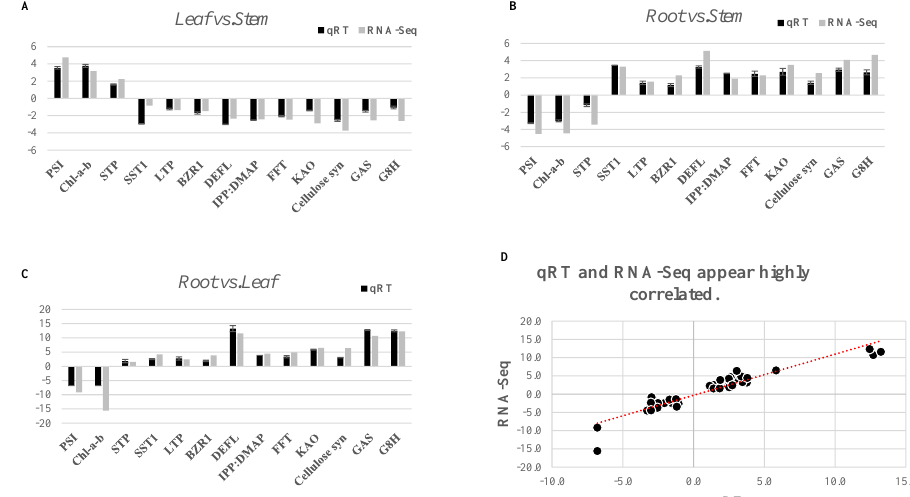
Figure 9. qRT-PCR based validation of RNA-Seq data using 13 unigenes involved in terpenoid biosynthesis (IPP: DMAP, KAO, GAS, G8H), photosynthesis (PSI, Chl-a-b), starch and sucrose metabolism regulating inulin biosynthesis (STP, SST1, FFT, cellulose syn), and antiviral pathogenesis (BZR1, DEFL, LTP) in ( A ) Leaf vs. Stem; ( B ) Root vs. Stem and ( C ) Root vs Leaf tissue. ( D ) Correlation plot representing strong correlation between RNA-Seq and qRT-PCR